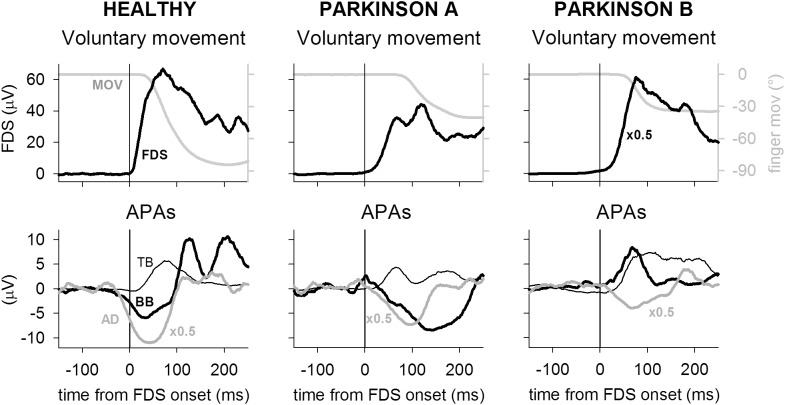
Recordings from one representative participant of the healthy group (HEALTHY) are compared to recordings of two PD patients (PARKINSON A and B). Each trace is the average of 45 recordings, time aligned on the onset of the prime mover flexor digitorum superficialis (FDS). In each participant, top panel shows the FDS activation, matched to the ensuing finger flexion (MOV); bottom panel illustrates the intra-limb APAs in TB, BB, and AD. For illustration purpose, the mean reference signal level, recorded from 750 to 250 ms before FDS onset, has been subtracted from each EMG trace. FDS amplitude has been down-scaled by a factor 2 in patient B and AD amplitude has been down-scaled by a factor 2 in all participants. Note that in the healthy participant the FDS activation was shortly followed by index-finger flexion but preceded by inhibitory intra-limb APAs in BB and AD and almost synchronous with an excitatory intra-limb APA in TB. In both PD patients, finger flexion delay was larger than in the healthy participant, while APAs timing actually showed a delay. However, while patient A produced the same intra-limb APA pattern observed in healthy individuals, patient B had an inverted intra-limb APA in BB, which underwent excitation instead of inhibition.